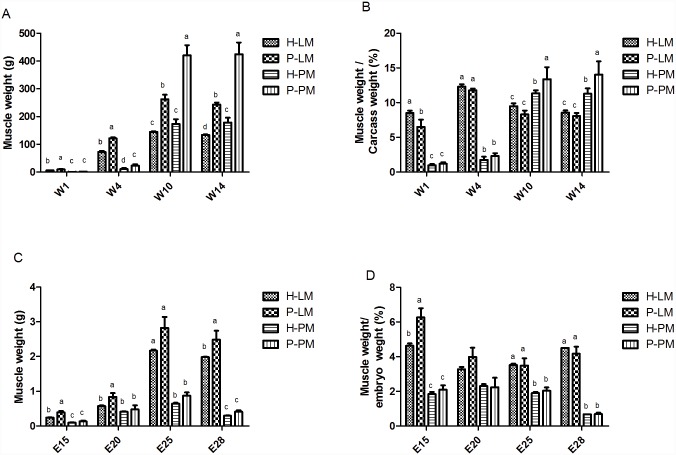
Skeletal muscle variations in leg muscle (LM) and pectoral muscle (PM) between Heiwu duck (H) and Peking duck (P) during development.A. The increase in the weight of four skeletal muscles from post-hatching week 1 (W1) to week 16 (W14). B. The changing rate of skeletal muscle weight to carcass weight from post-hatching week 1 (W1) to week 16 (W14). C. The variation in the weight of the four skeletal muscles in embryo from embryonic day 15 (E15) to day 28 (E28). D. The changing rate of skeletal muscle weight to carcass weight from embryonic day 15 (E15) to day 28 (E28). At each time point (W1, W4, W10, etc), statistically significant differences are indicated by different letters (a, b, c, etc). At a given time point, any samples that are not significantly different are labeled with the same letter.